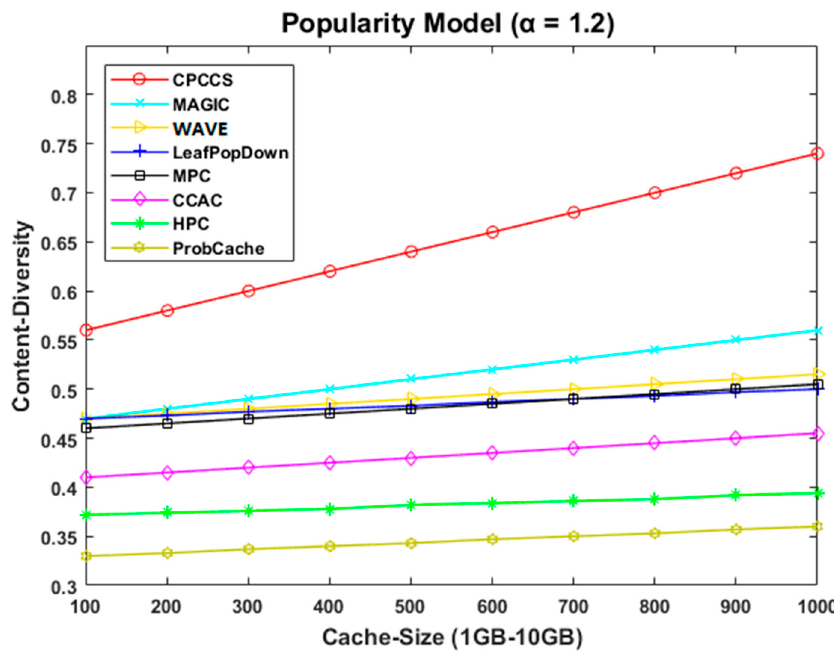
Figure 5. Content diversity with VoD.